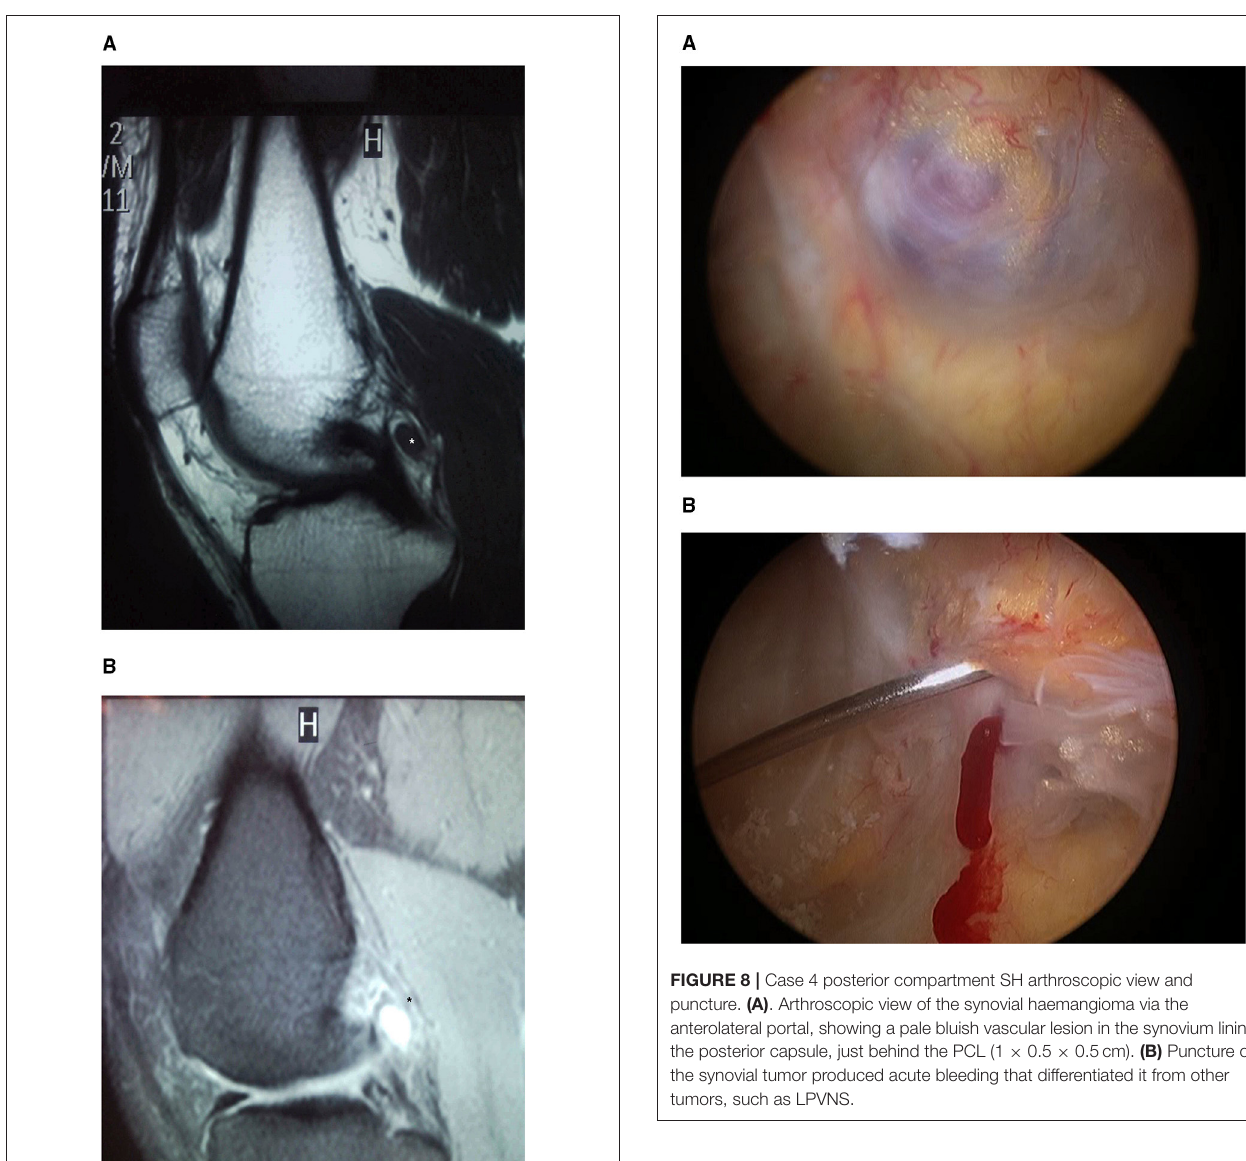
haemangioma was scarce (19.8%) and usually not reported (51%). The diagnosis was normally made late and the average delay was 6.8 ± 8.6 years.